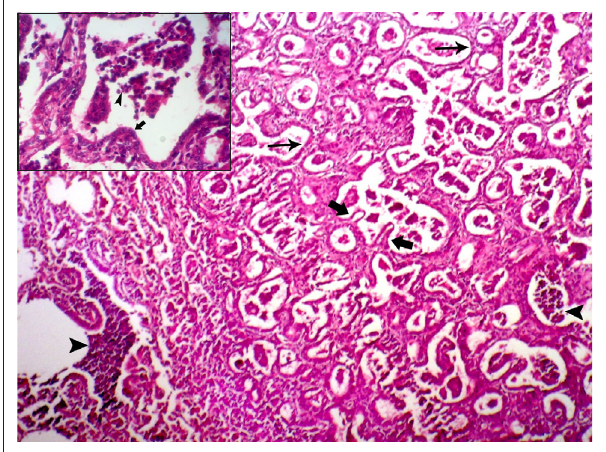
FIGURE 2: Section from a lung with classic ovine pulmonary adenocarcinoma. Note: acinar (thin arrows) to papillary (thick arrows) proliferation of alveolar epithelial cells is superimposed on the purulent bronchopneumonia (arrow heads) (H&E, ×100). Cellular details are shown at a higher magnification in the top left hand corner (×400).